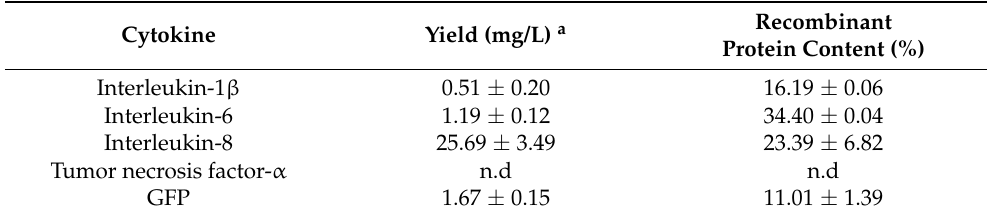
Table 2. Cytokine IB yields (mg/L culture) and recombinant protein content (%) of each cytokine nanoparticle produced in L. lactis ; n.d: